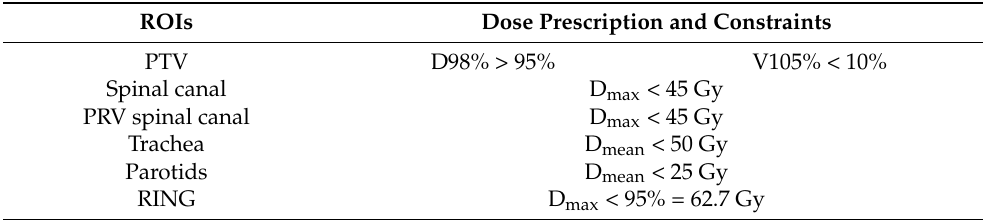
Table 4. Dose prescription and constraints to organs at risk employed for the generation of the dose distributions for the sensitivity study.